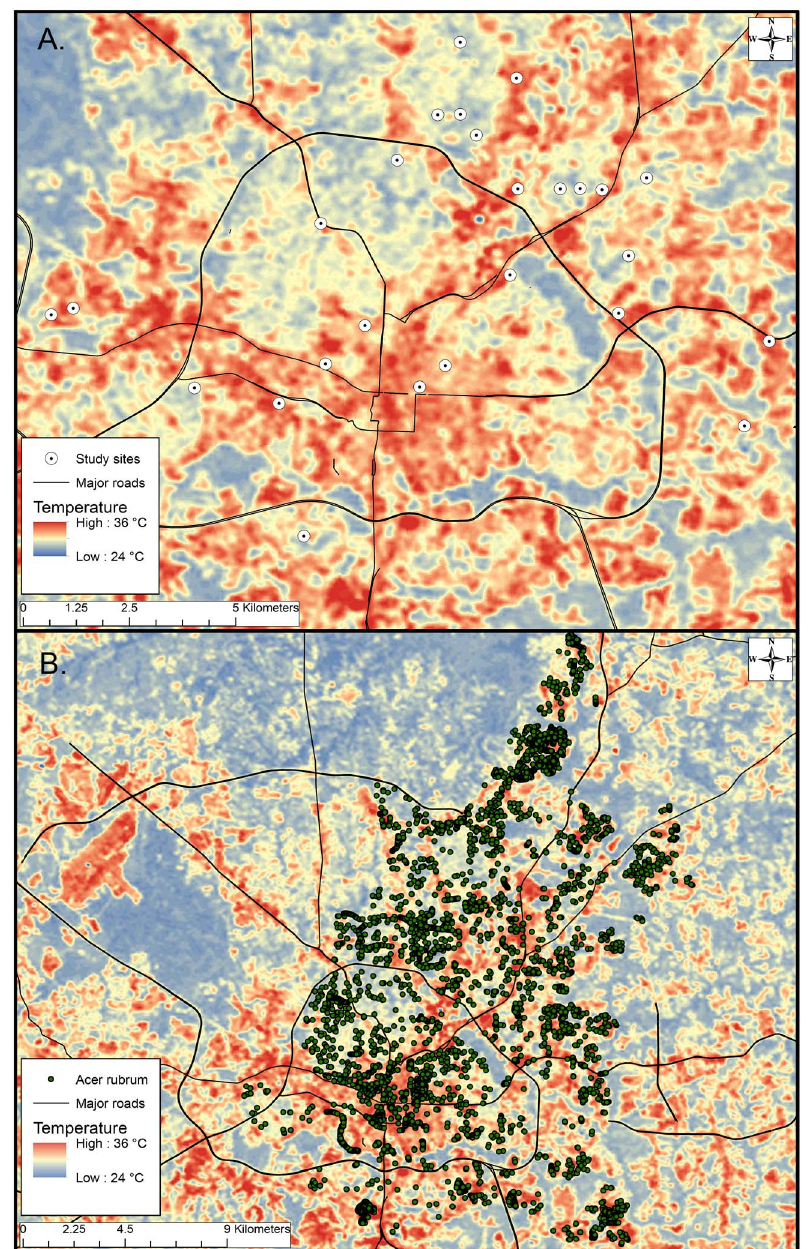
Figure 1. Thermal map of Raleigh, NC on August 18 2007. Temperature ranges from 24 to 36 u C designated by the darkest blue and red regions, respectively. (a) Study site selection for M. tenebricosa abundance survey, water potential measurement, growth measurements, and condition rating. (b) City-wide red maple street tree dataset of over 8000 trees overlaid on a surface temperature thermal image of Raleigh, NC.